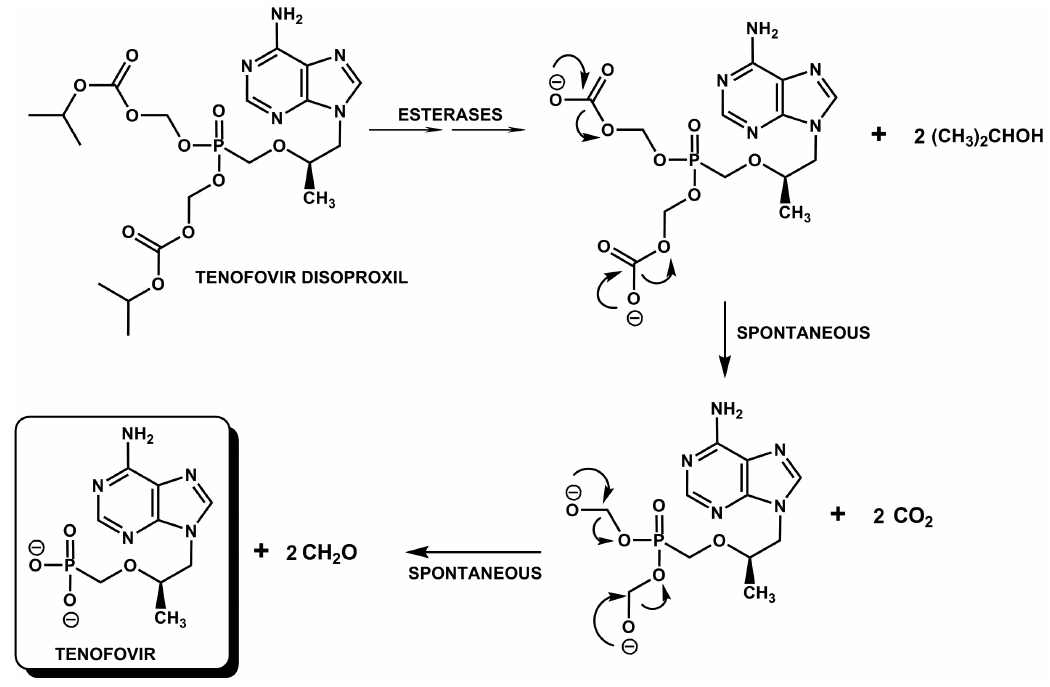
FIGURE 17 - Chemical and enzymatic hydrolysis of tenofovir disoproxil fumarate into its active component,